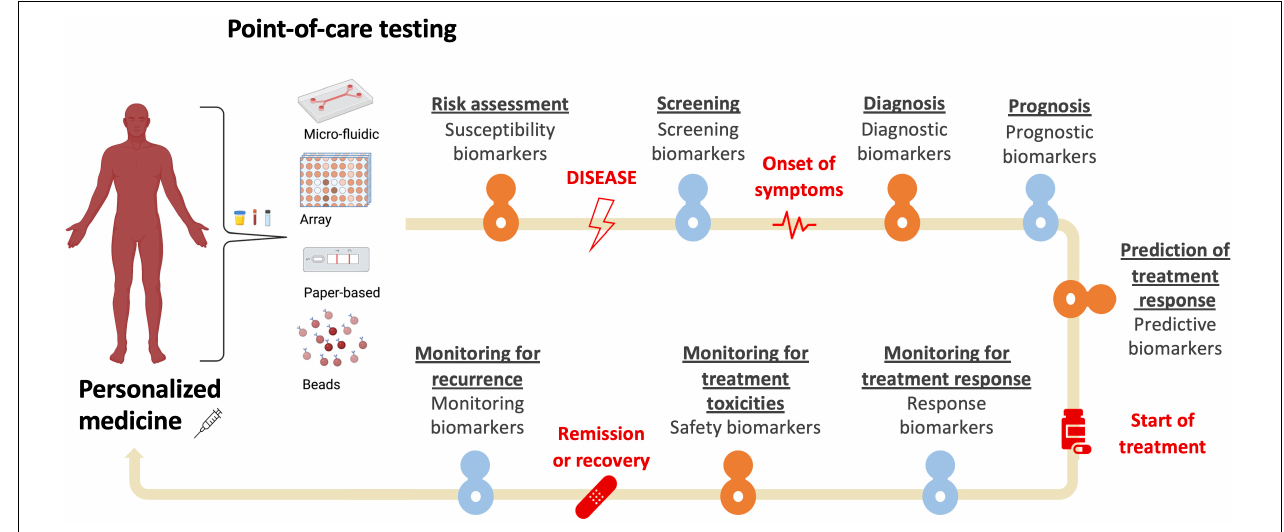
FIGURE 1 | Types of biomarkers.